Question: In a single sentence, describe what this figure presents.
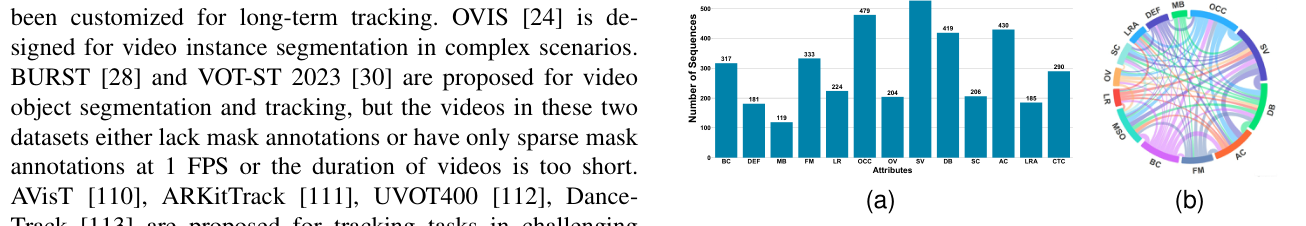
Answer: Attributes distribution in LVOS. In sub-figure (b), the link indicates the high likelihood that more than one attributes will appear in a sequence. Best viewed in color.